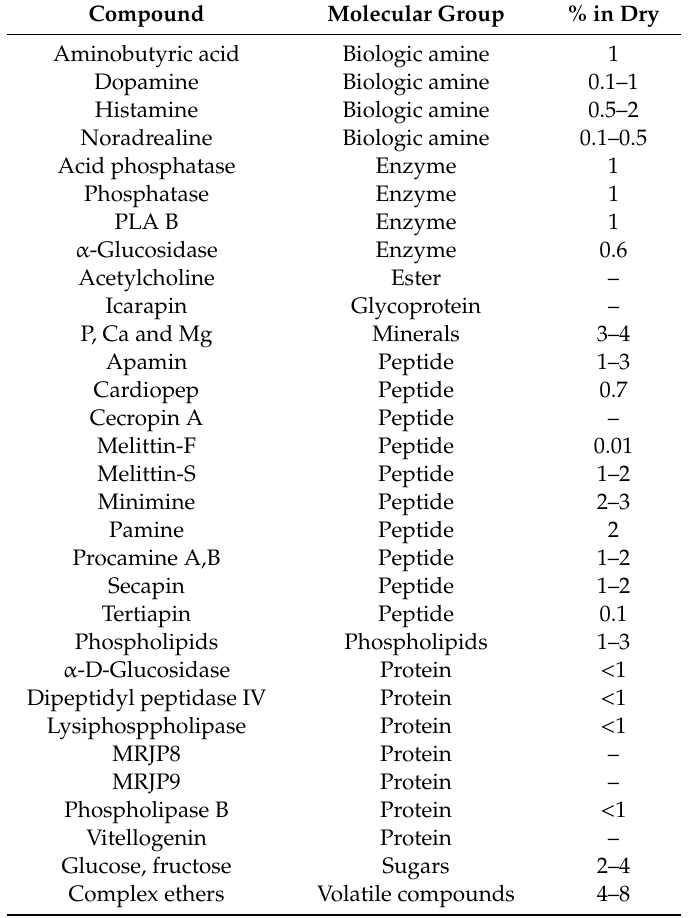
Table 2. Minor components of BV and percentage in dry weight. Based on